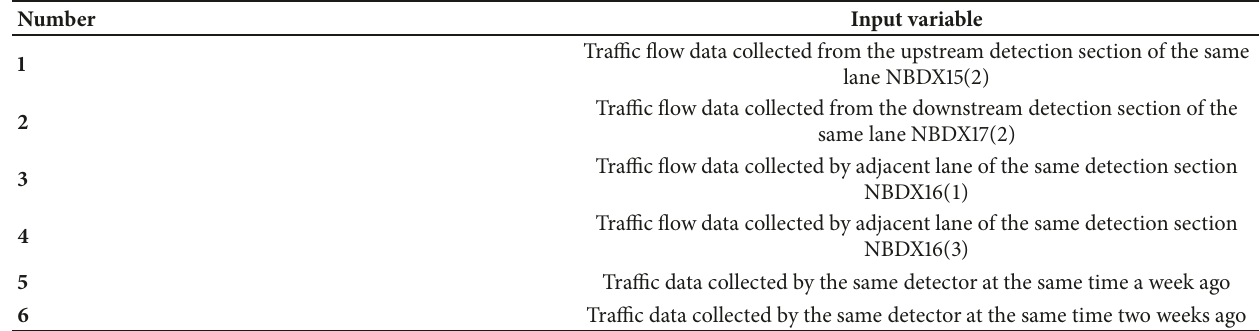
Table 1: The input variable of forecasting model.